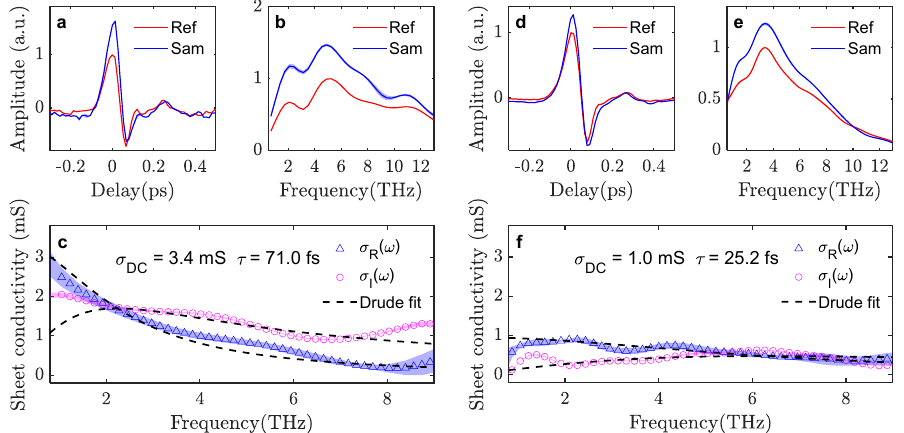
Figure 6. Reflection-mode measurement results. ( a,b ) Reflection waveform and spectra through bare PET (Ref) or through graphene/PET (Sam) in the incident THz field strength of 60 kV/cm. Light red and blue bands indicate the experimental standard deviation between scans. ( c ) Extracted complex-valued conductance spectrum of the graphene under low THz field strength (together with the Drude model fitting curves). Light blue and magenta bands indicate the standard deviation of the calculated conductance. ( d,e ) Reflection waveform and spectra (Ref and Sam) with the incident THz field strength of 1050 kV/cm. ( f ) Extracted and fitted conductance spectra under strong THz field